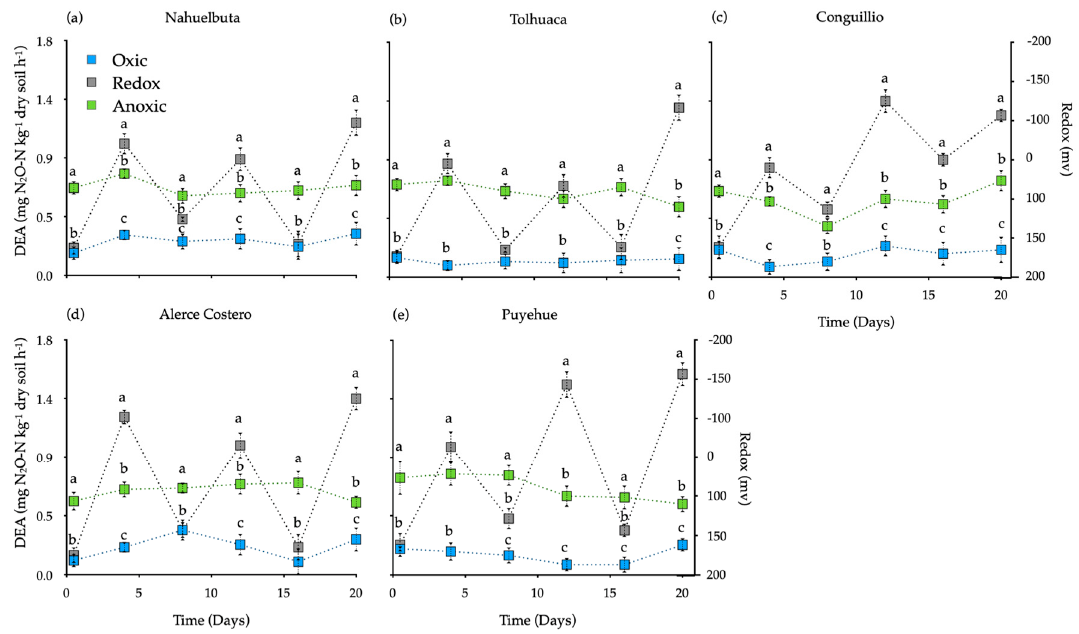
Figure 5. Denitrification enzyme activity (DEA) in soils inoculated with white-rot fungi in various temperate rain forest soils incubated for 20 days under oxic, anoxic, and fluctuating redox conditions. Reference letter in each panel ( a – e ) represents the five temperate forest soil sites. Bars indicate standard error of the mean ( n = 4). Different letters show significant differences ( p <